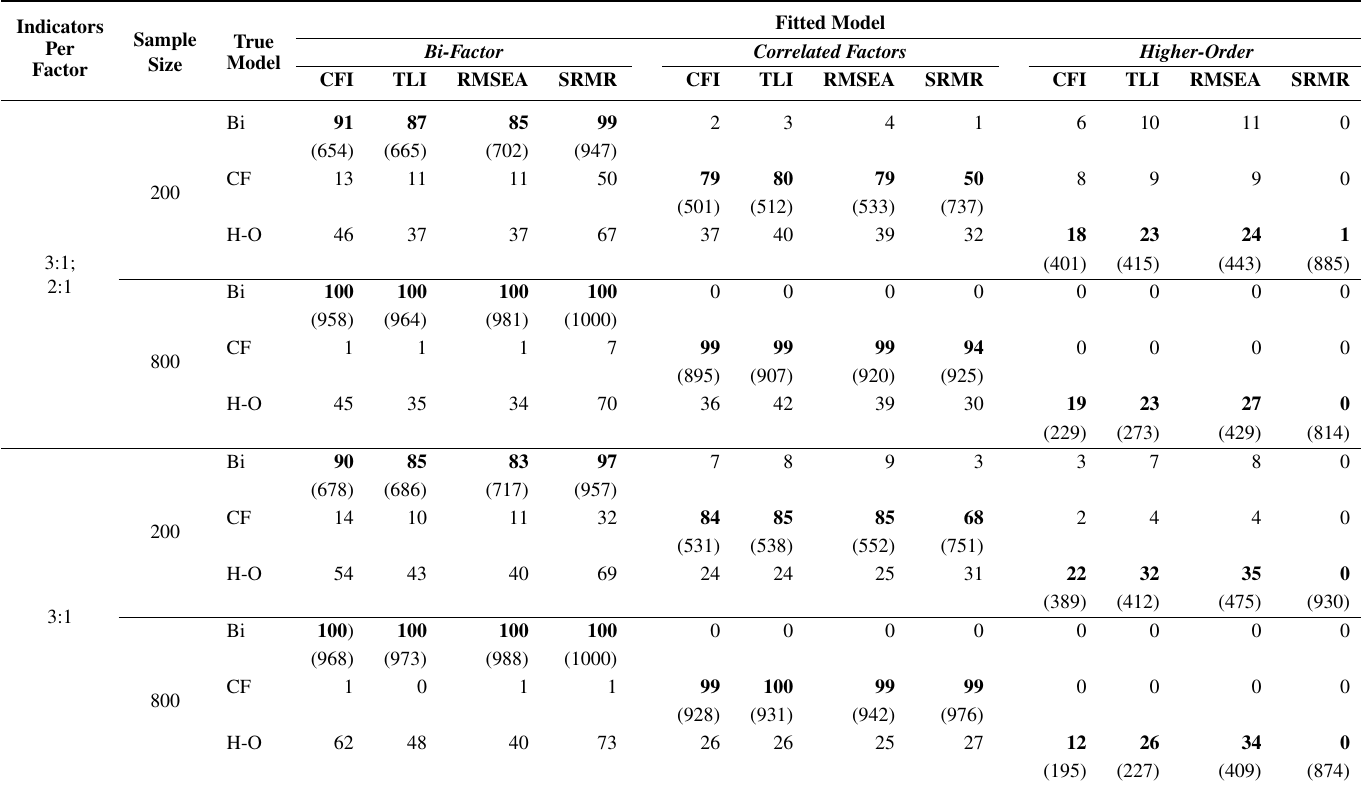
Table 3. Percentage of solutions selected by each approximate fit index when only one model fit best for each cell of the study design (rounded to nearest whole